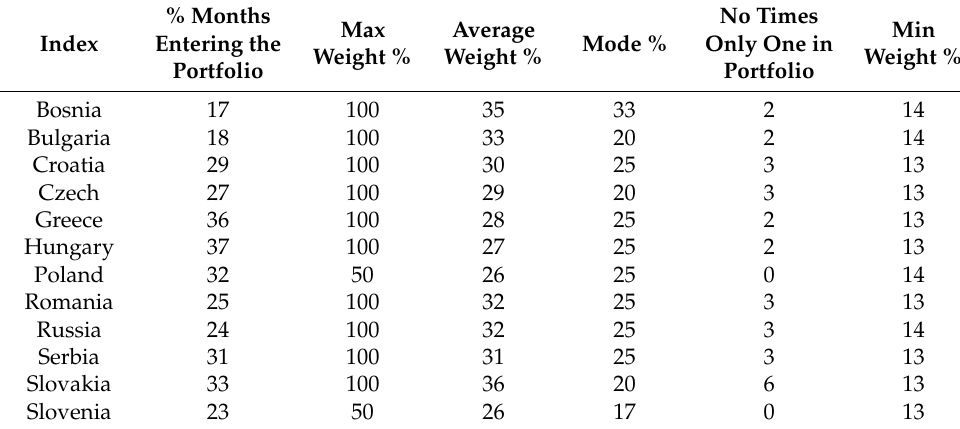
Figure 5. Portfolio weights for strategy_5. Table 2. Analysis of portfolio weights of strategy_5.